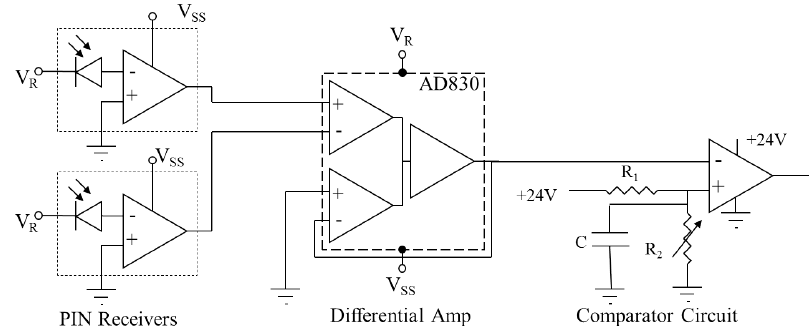
Figure 4. Schematic of the PLC FOS digital input interface, including the receivers, differential amplifier and comparator circuit.